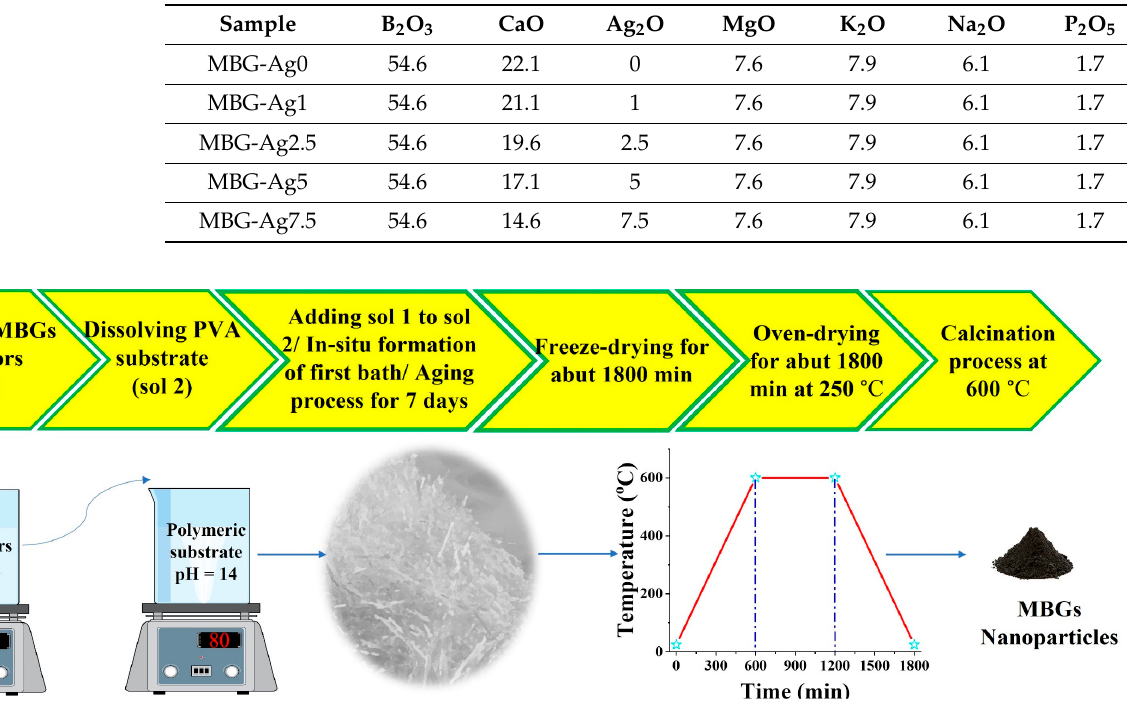
Figure 1. Schematic representation of the sol–gel synthesis process of 1393B3 borate BGs by using a polymeric substrate (PVA).